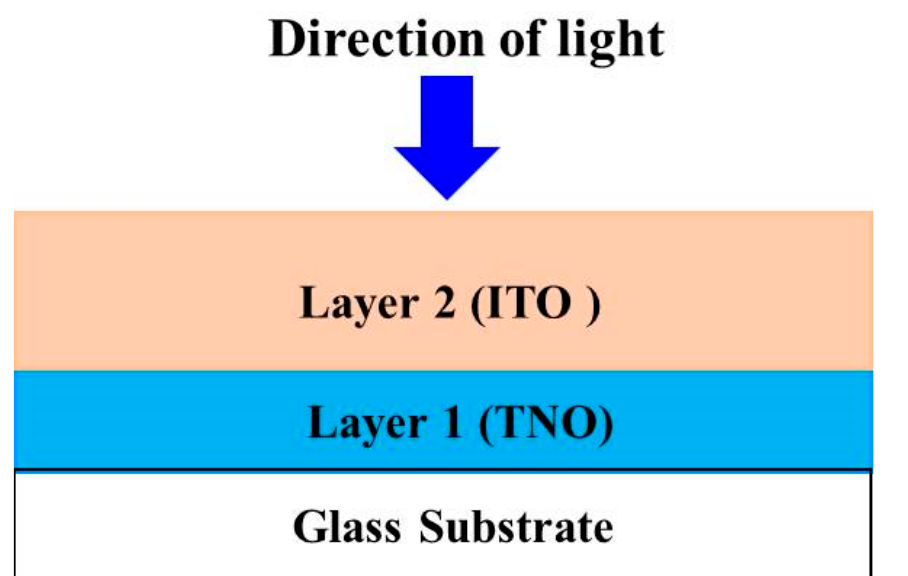
Figure 1. Schematic diagram of double-layer indium-tin oxide (ITO)/ Ti 1-x Nb x O 2 (TNO) on the glass substrate and the direction of light.